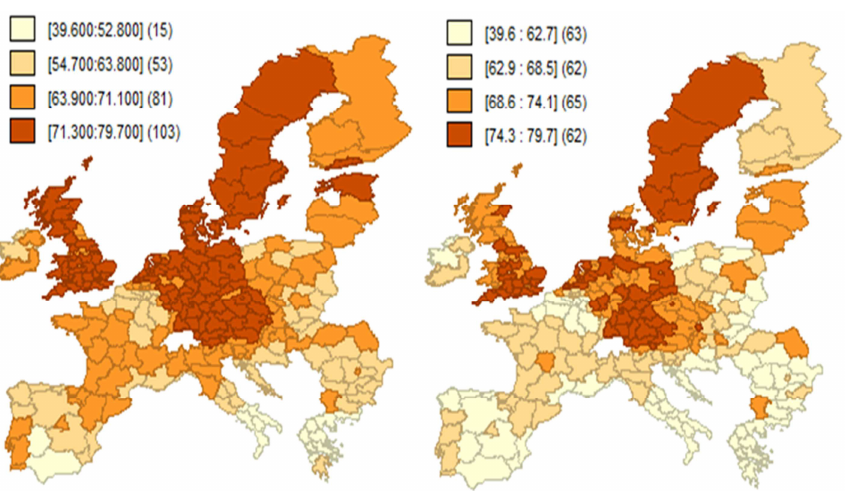
Figure 3. Natural breaks (left) and quantile (right) maps of employment rate